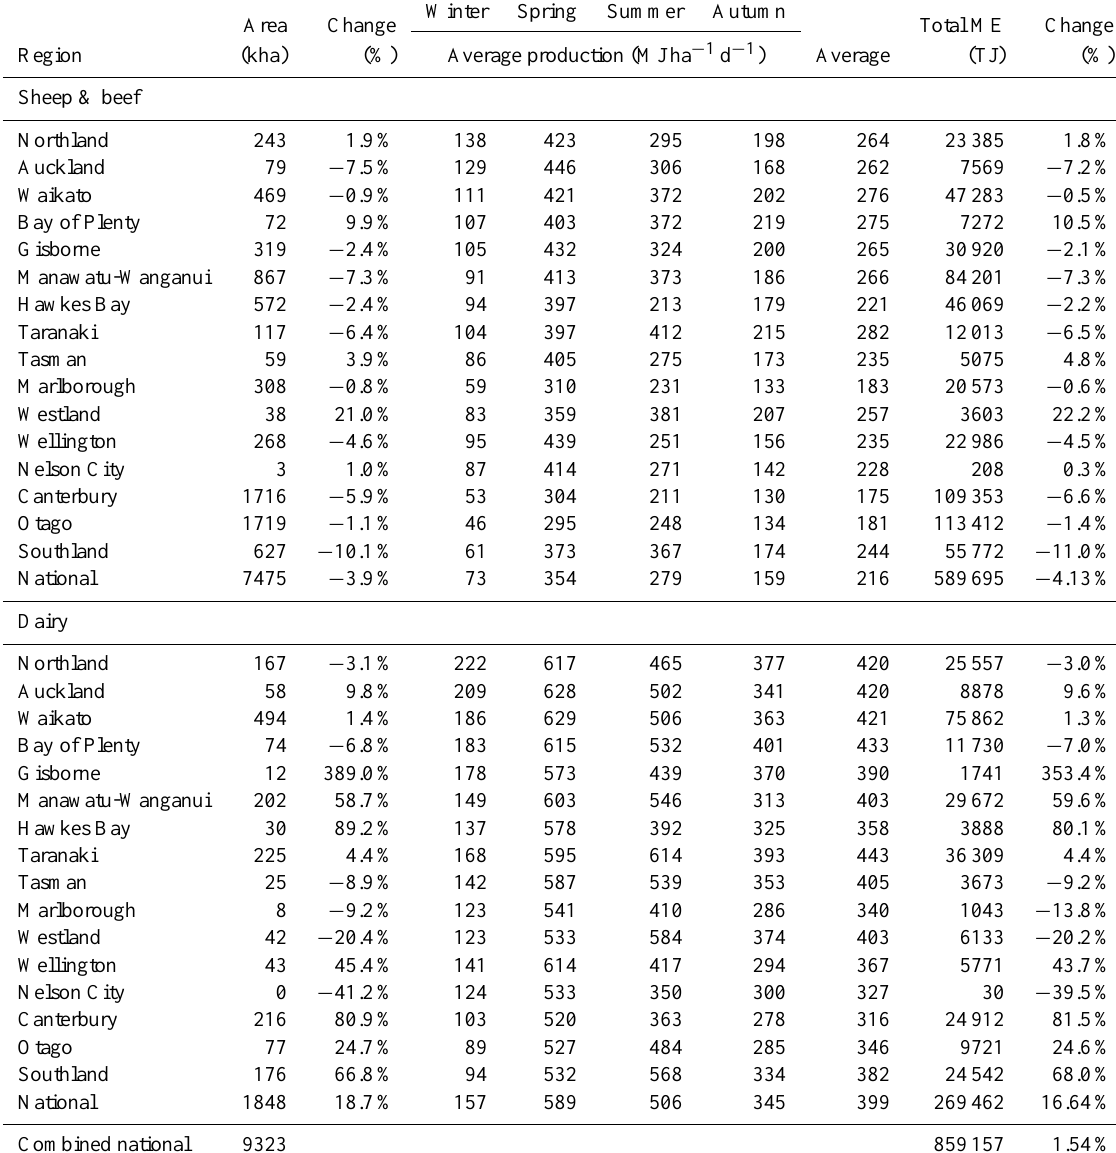
Table B13. Land-use change, 2050 CO 2 = NZD50 per tonne. Winter Spring Summer Autumn Area Change Total ME Change Region (kha) (%) Average production (MJha − 1 d − 1 ) Average (TJ) (%) Sheep & beef Northland 243 1.9% 138 423 295 198 264 23385 1.8% Auckland 79 − 7.5% 129 446 306 168 262 7569 − 7.2% Waikato 469 − 0.9% 111 421 372 202 276 47283 − 0.5% Bay of Plenty 72 9.9% 107 403 372 219 275 7272 10.5% 319 324 265 30920 − 2.1% 867 − 7.3% 91 413 373 186 266 84201 − 7.3% 572 − 2.4% 94 397 213 179 221 46069 − 2.2% 117 − 6.4% 104 397 412 215 282 12013 − 6.5% Tasman 59 3.9% 86 405 275 173 235 5075 4.8% Marlborough 308 − 0.8% 59 310 231 133 183 20573 − 0.6% Westland 38 21.0% 83 359 381 207 257 3603 22.2% Wellington 268 − 4.6% 95 439 251 156 235 22986 − 4.5% Nelson City 3 1.0% 87 414 271 142 228 208 0.3% Canterbury 1716 − 5.9% 53 304 211 130 175 109353 − 6.6% Otago 1719 − 1.1% 46 295 248 134 181 113412 − 1.4% Southland 627 − 10.1% 61 373 367 174 244 55772 − 11.0% National 7475 − 3.9% 73 354 279 159 216 589695 − 4.13% Dairy Northland 167 − 3.1% 222 617 465 377 420 25557 −